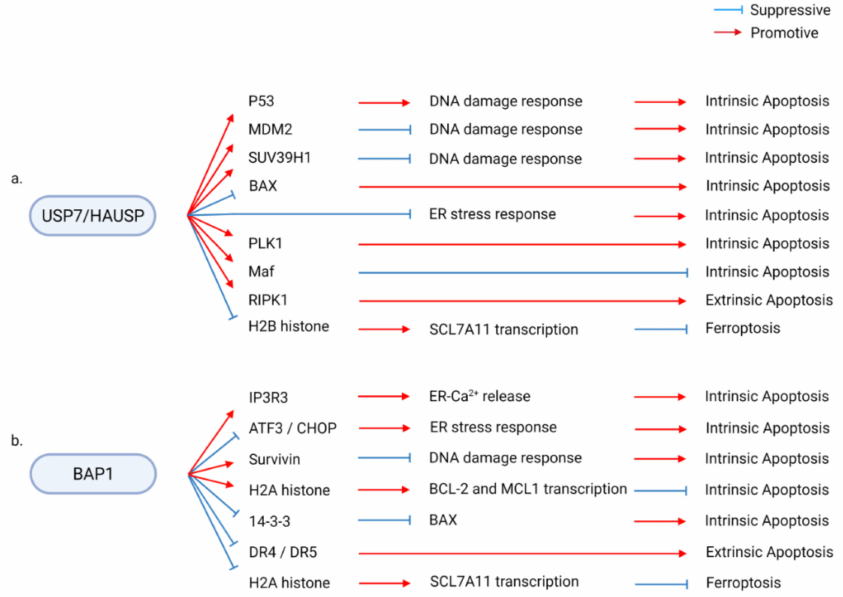
Figure 3. Examples of diverse molecular pathways involved in the deubiquitinase (DUB)/regulated cell death (RCD) regulatory axis. DUBs interact with multiple signaling path- ways to modulate diverse types of RCD. ( a ) USP7/HAUSP modulates p53, MDM2, SUV39H1, BAX, PLK1, Maf, RIPK1, and H2B histone to enhance or suppress diverse types of RCD, including intrinsic apoptosis, extrinsic apoptosis, and ferroptosis. ( b ) Similarly, the BAP1/RCD axis is mediated by diverse downstream pathways consisting of components, such as IP3R3, ATF3, CHOP, survivin, H2A histone, 14-3-3, and